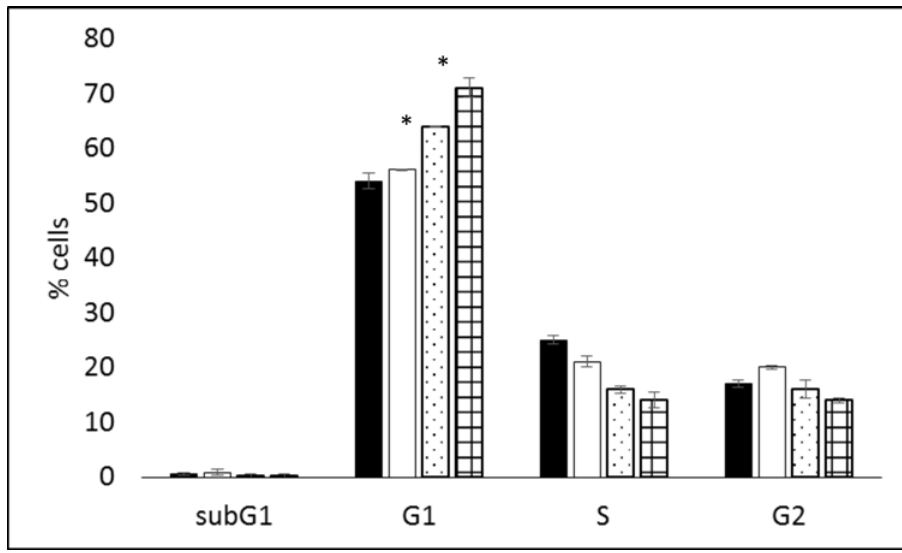
Fig 7. Cell cycle distribution in MDA-MB-468 cells treated with metformin for 24h (white), 48h (speckle) and 72h